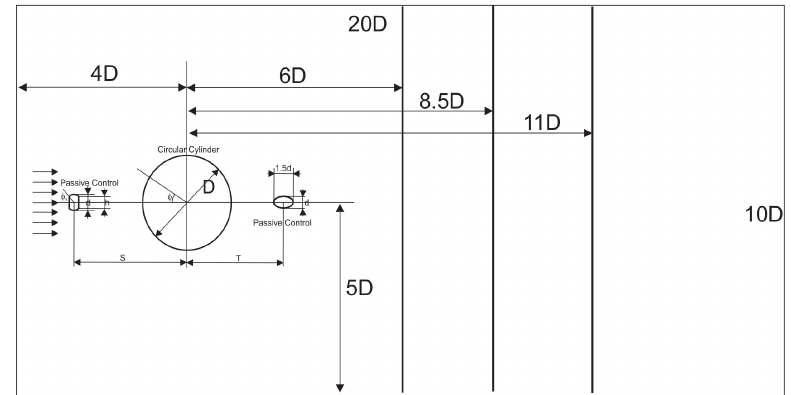
Figure 2. Designed research